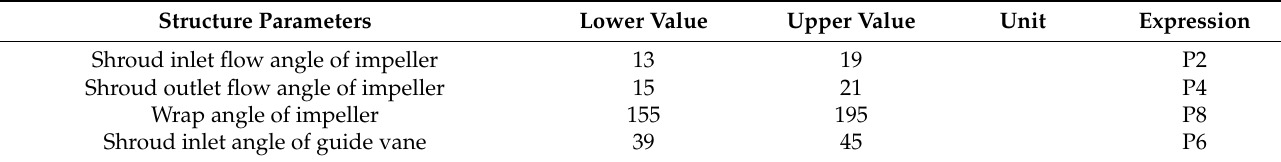
Table 3. The range of values of structural parameters.